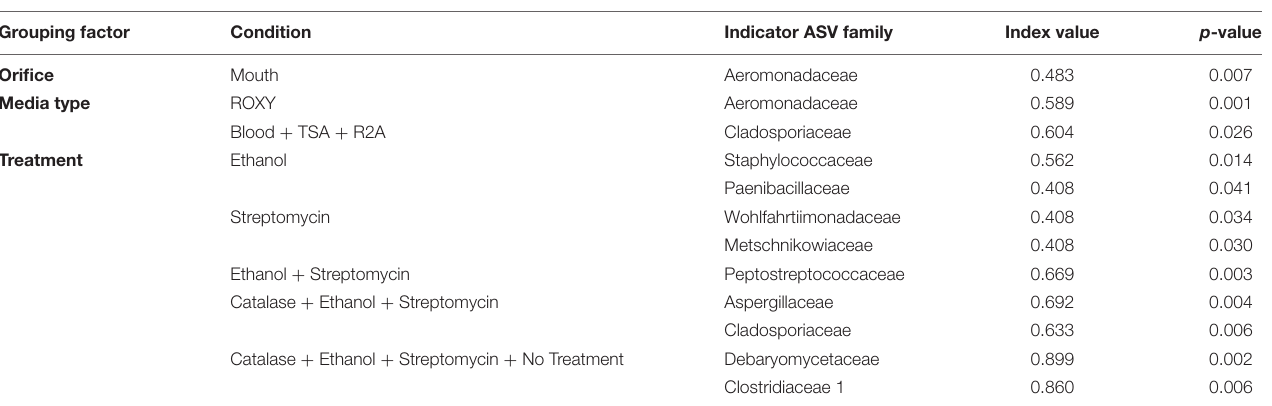
FIGURE 3 | Beta diversity measured in Jaccard distance and NMDS ordination. Differences in microbial community structure were driven by orifice and treatment, specifically ethanol and streptomycin. Shape corresponds to orifice sampled, while color differentiates between treatments of the medium or inoculum. TABLE 1 | Taxonomic associations with media type using indicator species